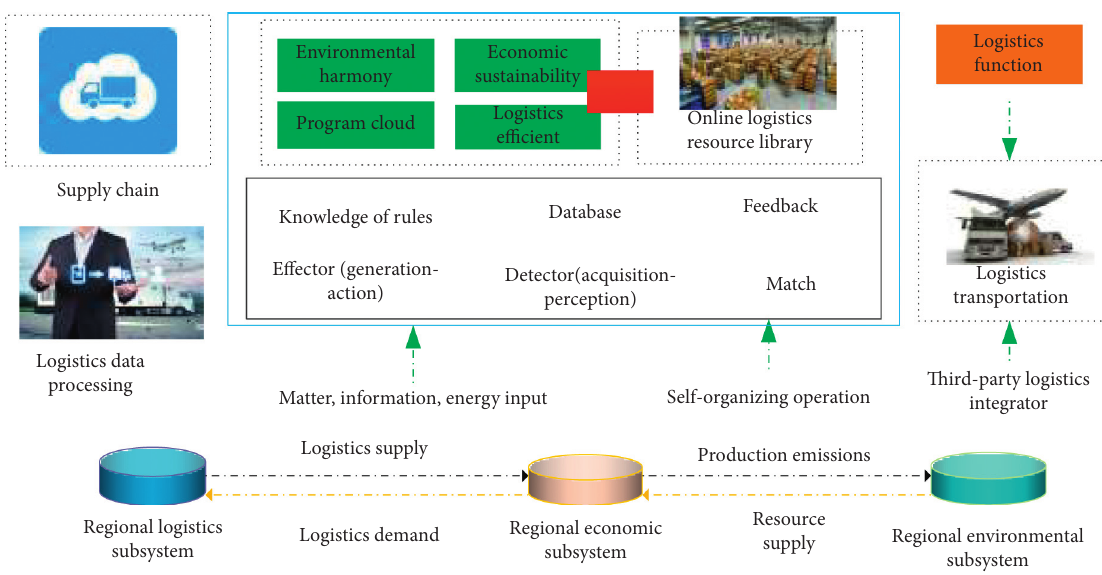
Figure 2: System coupling process.